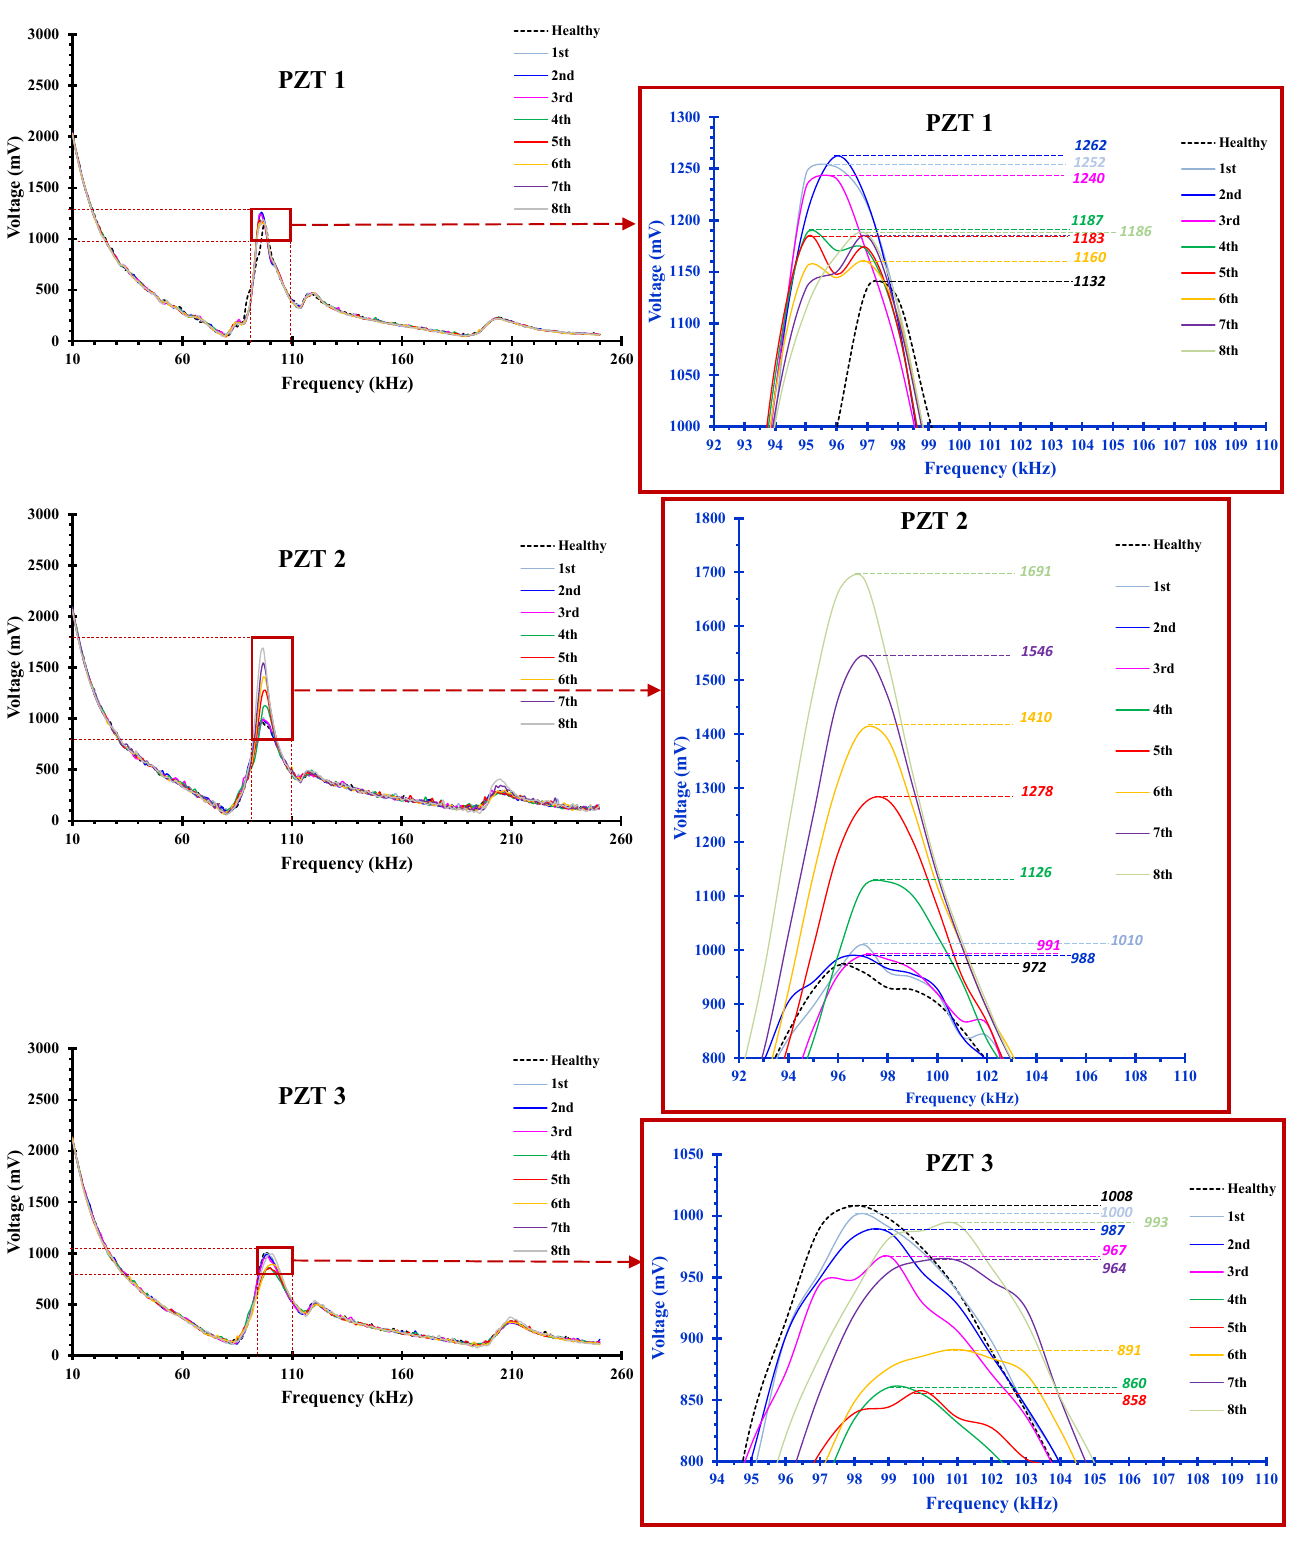
Figure 15. Frequency response of the PZT transducers attached to the concrete surface of the beam near the joint body (PZT 1) and to the surface of the C-FRP ropes that were diagonally epoxy-bonded on the panel of the joint body (PZT 2 and PZT 3) of the strengthened specimen JB0F. Each curve represents the voltage versus frequency of the PZT at the end of each loading step (unloaded condition).